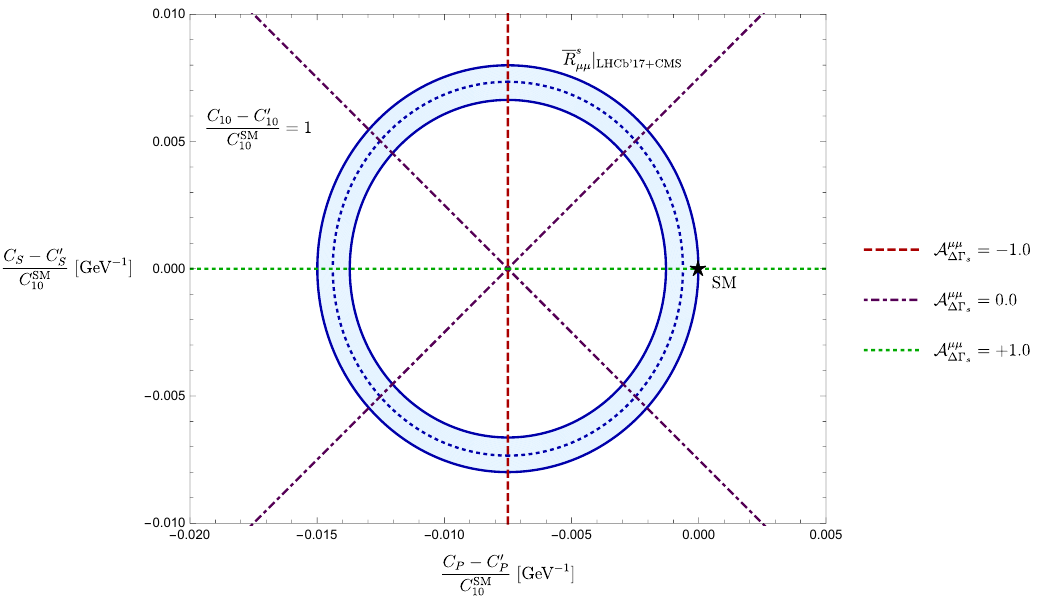
Figure 5 . Correlation between the ratios of Wilson coe(cid:14)cients in eq. (3.35) for the 1 (cid:27) range corresponding to the measured value of R blue circular band, and give lines for various values of